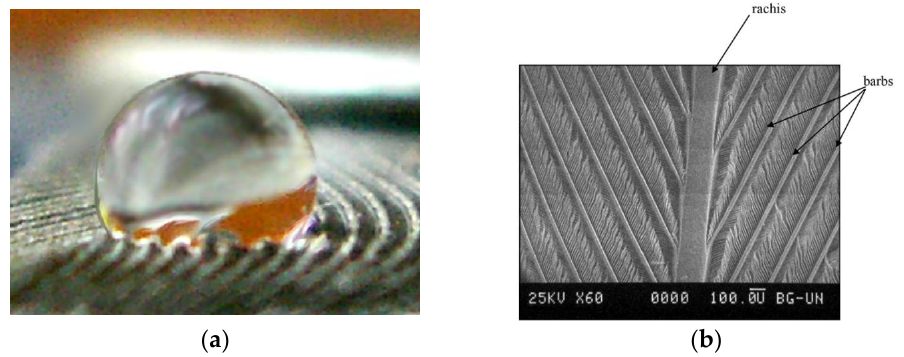
Figure 2. The superhydrophobic surface of bird feathers [2]; ( a ) general image of water droplets placed on bird feathers; ( b ) SEM image of the central part of a bird feather. Scale bar is 100 µm.